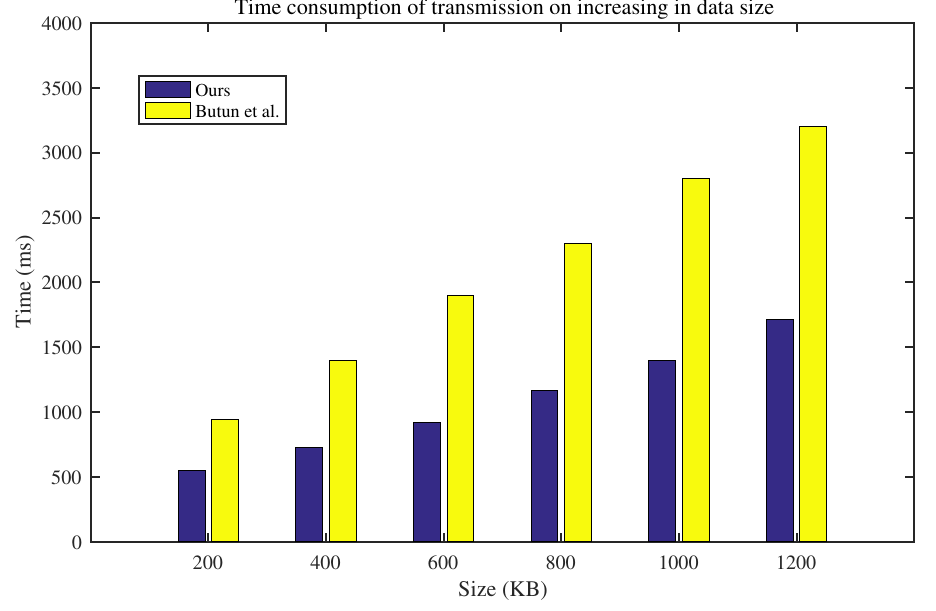
Figure 4. Time consumption of transmission with increasing data